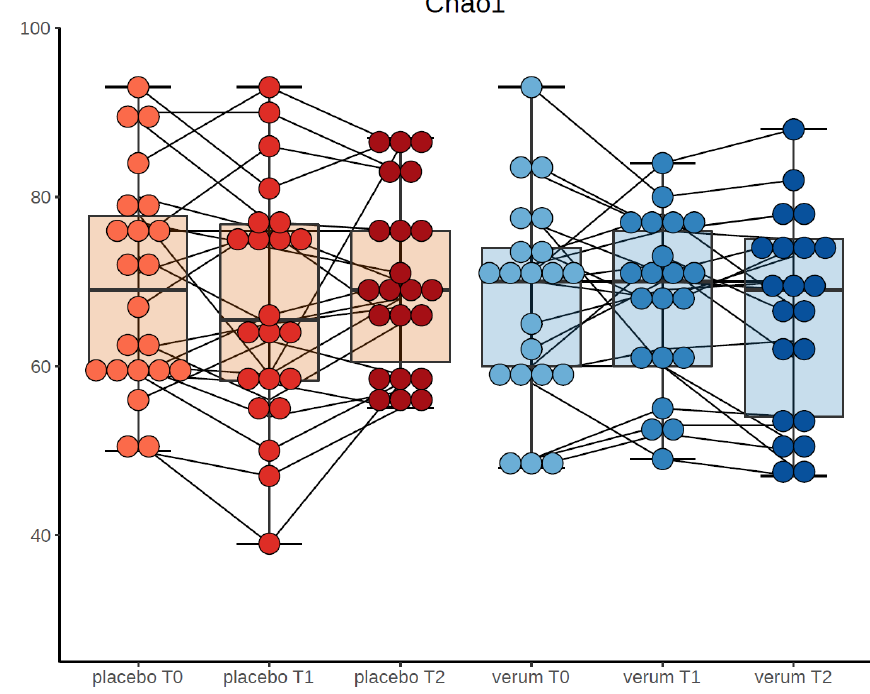
Figure 2. Chao-1-diversity at the three time points in probiotic and placebo group.